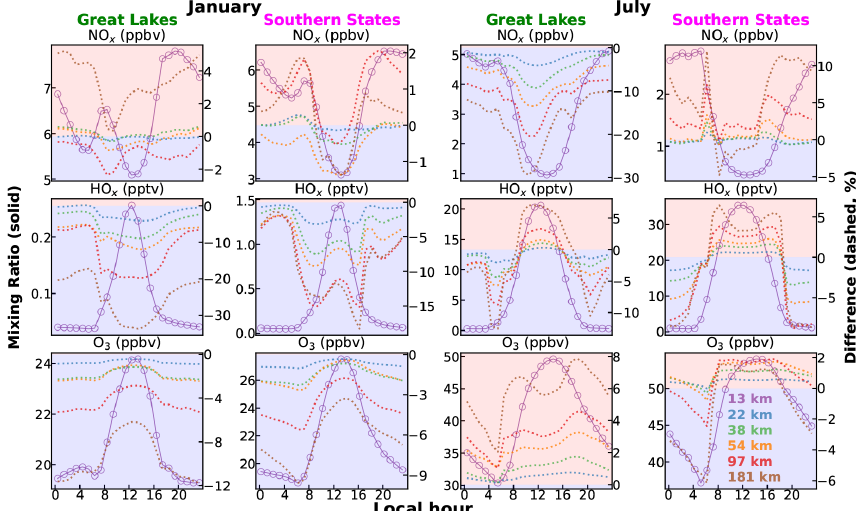
Figure 3. Resolution effects of surface NO x dominated by nighttime biases in January and by daytime biases in July 2015. The absolute monthly mixing ratios (left y axis) of regional mean NO x , HO x and O 3 are shown as circles and solid lines at 13km resolution, and the differences vs. 13km resolution (right y axis) are shown as dashed lines for the other resolutions (see legend in the lower-right subpanel). The positive (light red) and negative (light blue) difference regimes are divided by color.